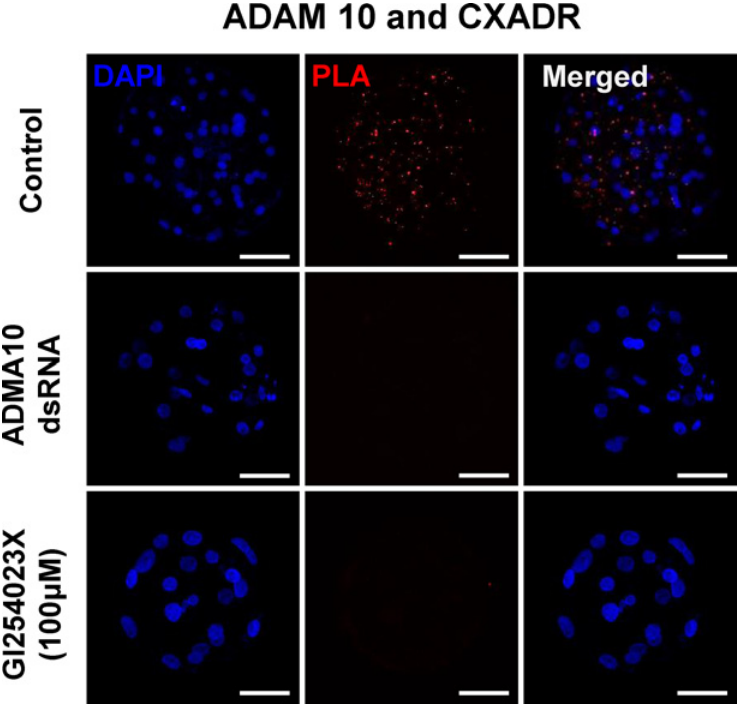
Fig 5. Proximity ligation assay (PLA) in blastocysts and hypothetical model for the roles of ADAM10 in embryo development. ADAM10 and CXADR interaction in porcine blastocyst using PLA. Control: 144 h.